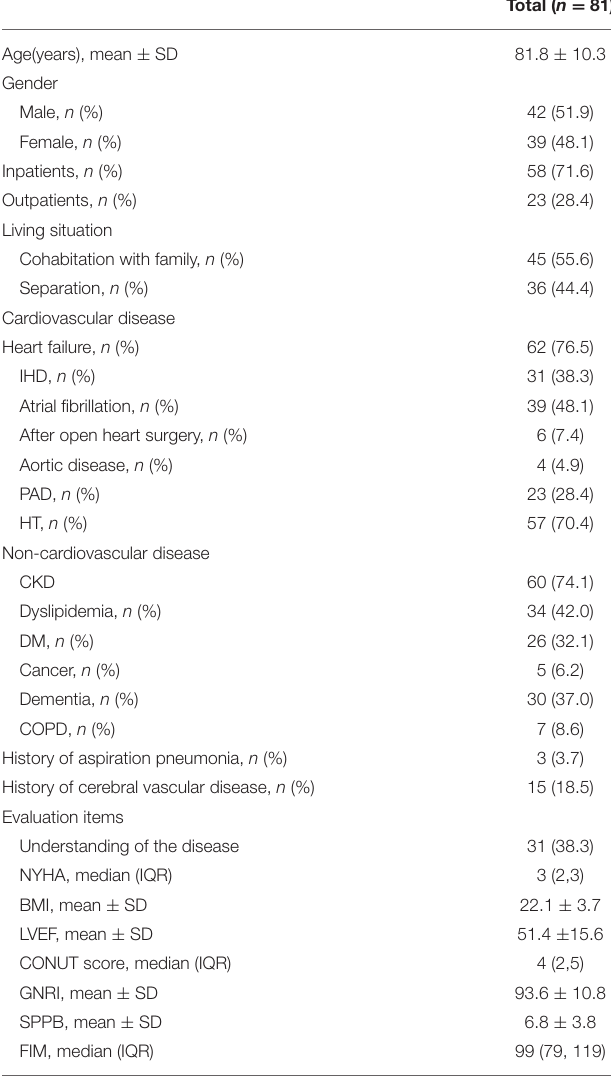
TABLE 2 | Patient